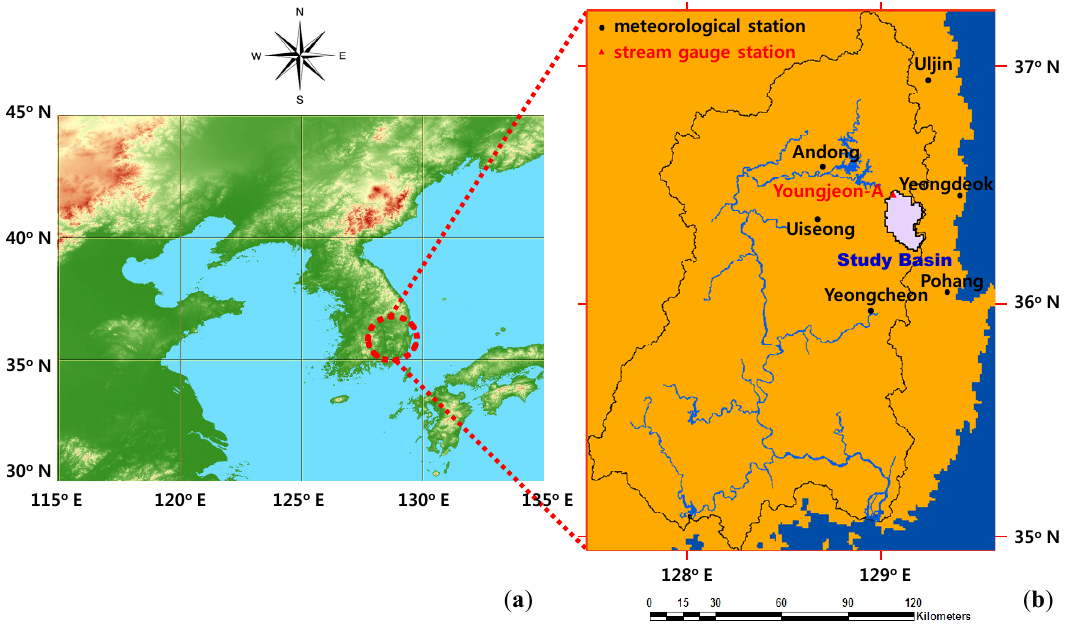
Figure 2. ( a ) Location map of the Korean Peninsula overlaid with latitude and longitude lines and ( b ) locations of gauge stations and the study basin overlaid with the main stream networks and the watershed boundary of the Nakdong